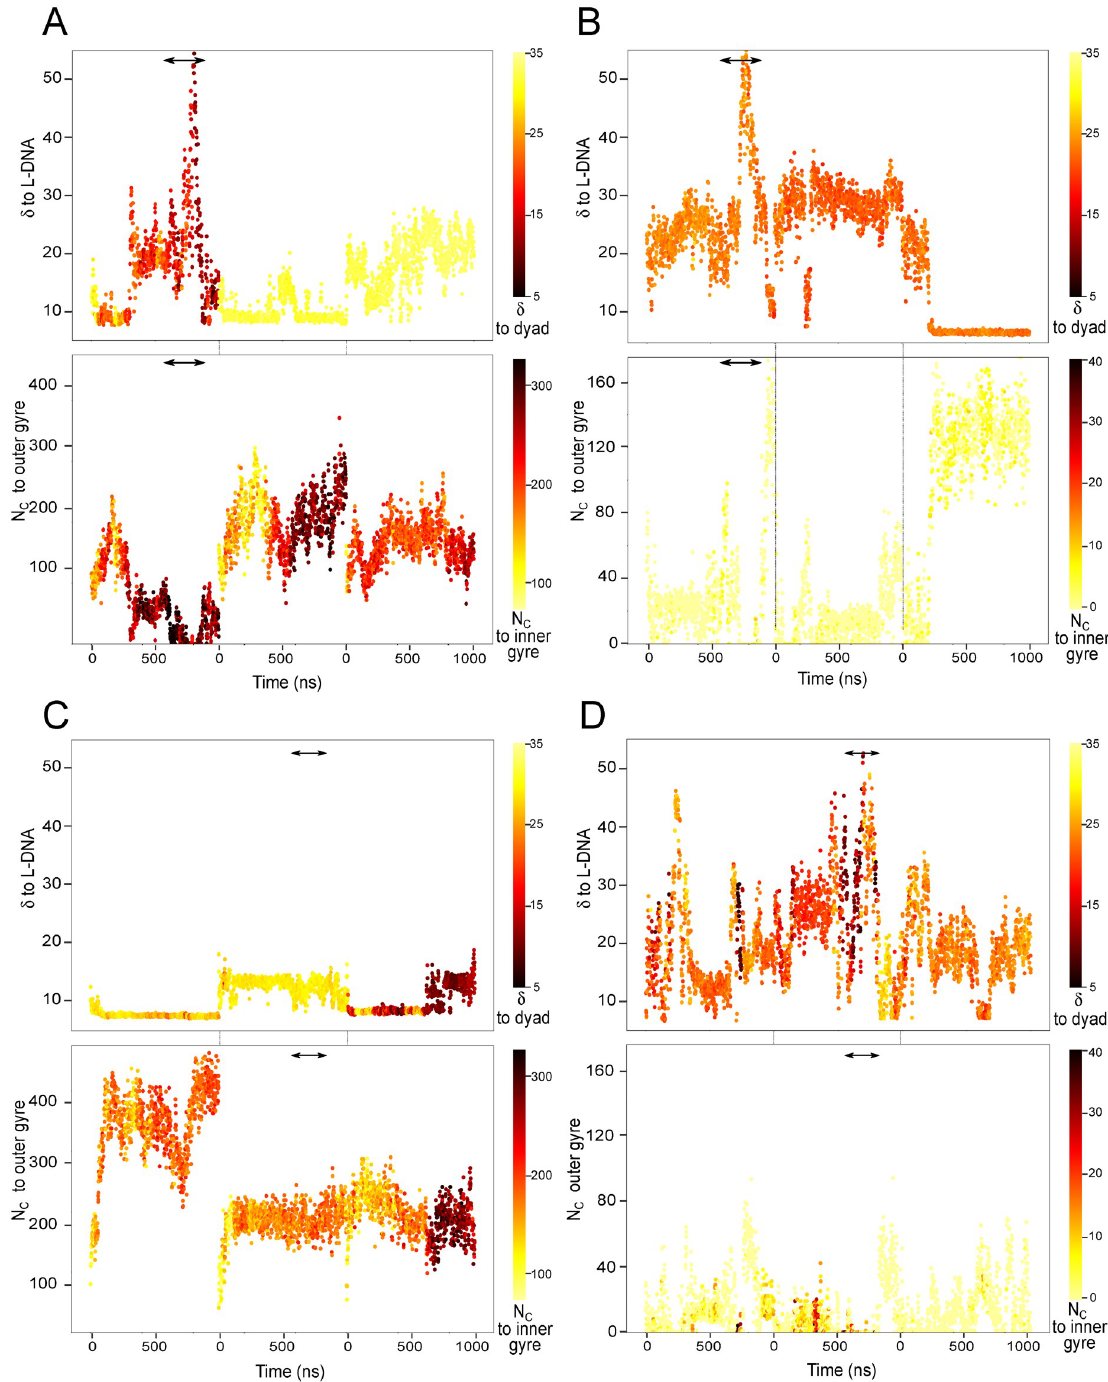
Fig 4. Configurations of the H3 and H2AC tails. Each panel shows the weighted mean distance ( δ ) to the L-DNA (top) and the number of contacts (N C ) with the outer gyre (bottom) during the simulations. The points are colored by the δ to the dyad and the N C with the inner gyre of the DNA (see Methods for details on the definition of inner and outer gyre). (A-B) H3 (A) and H2AC (B) tails at the 3’ end in the simulations of the Esrrb hH nucleosome. (C-D) H3 (C) and H2AC (D) tails at the 5’ end in the simulations of the Lin28b dH nucleosome (time series in S2 Data).